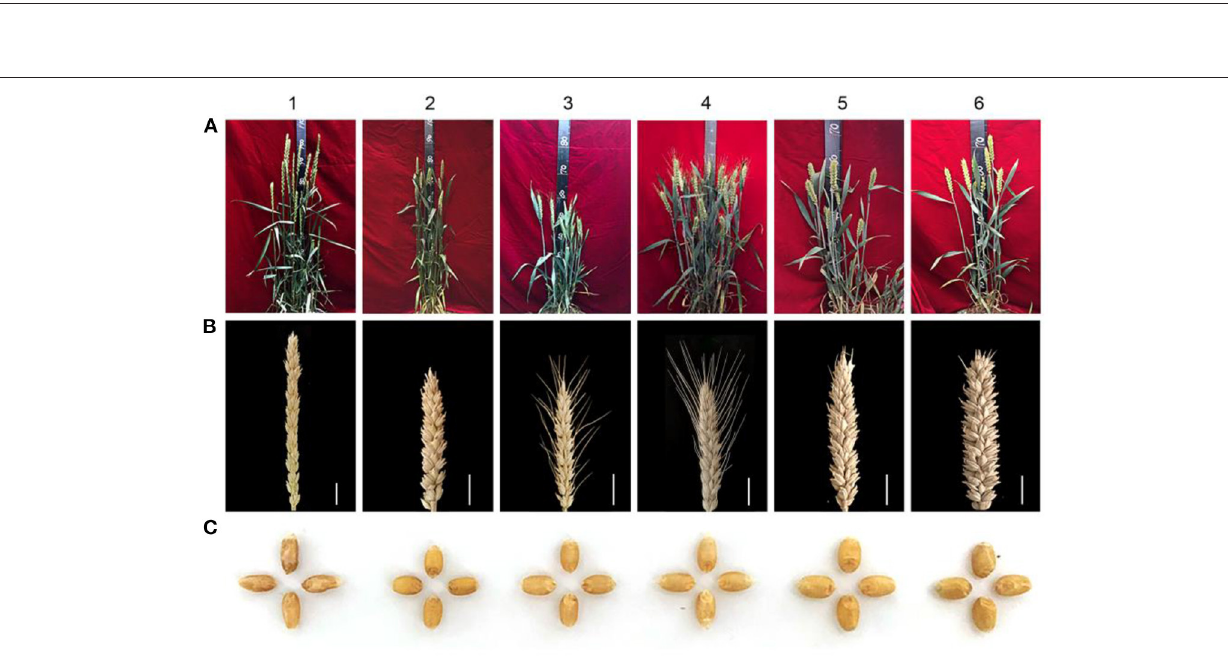
Frontiers in Plant Science |